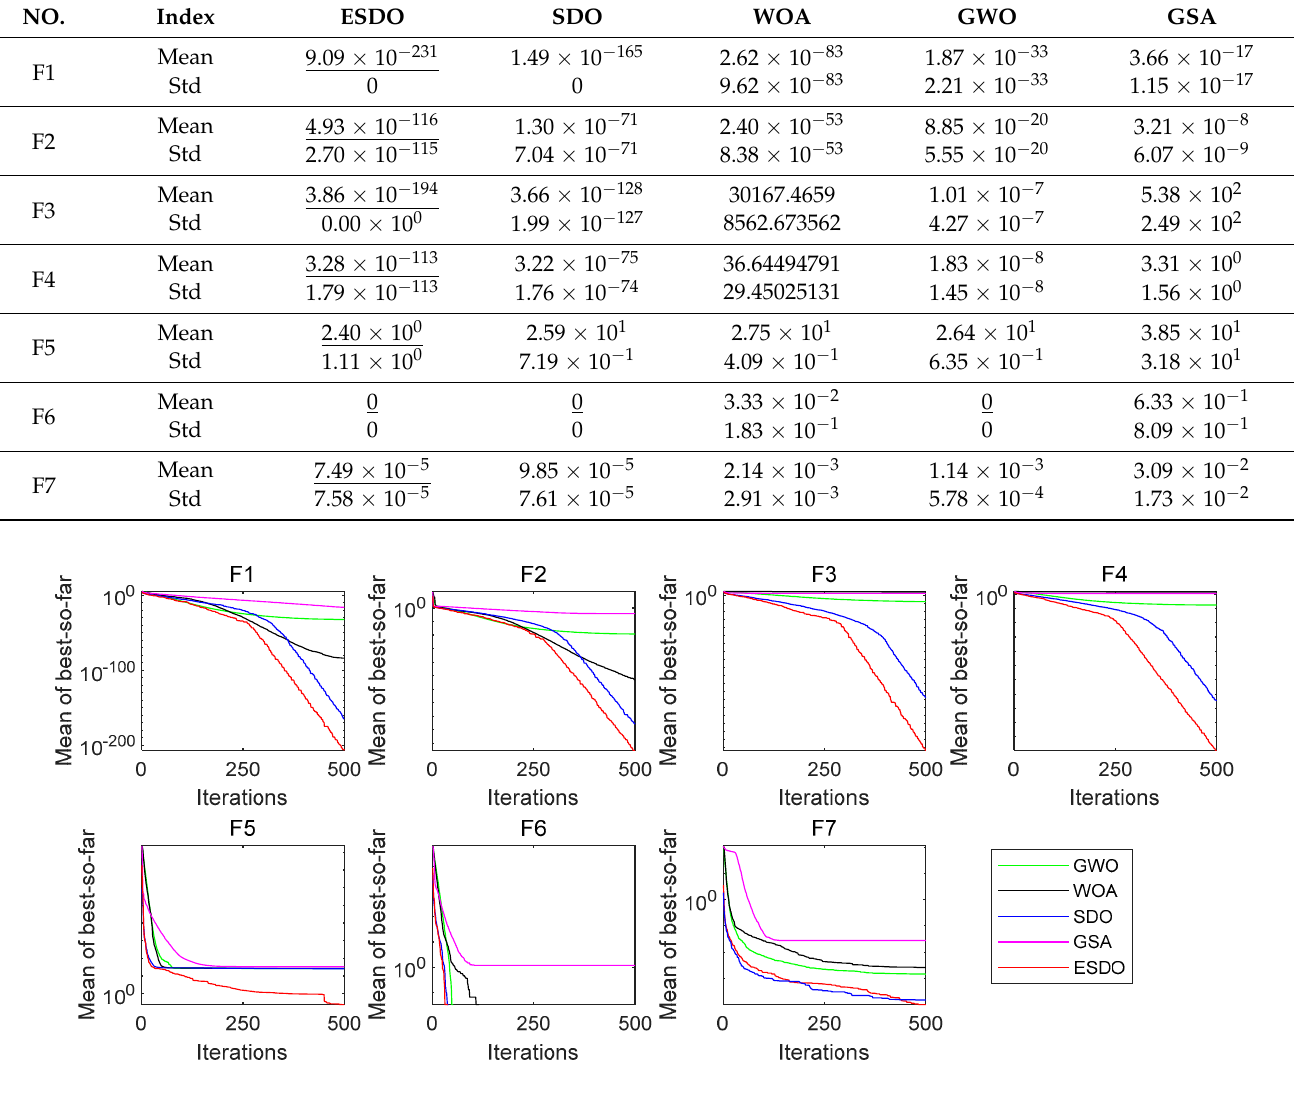
Figure 3. Convergence comparisons of UNs.